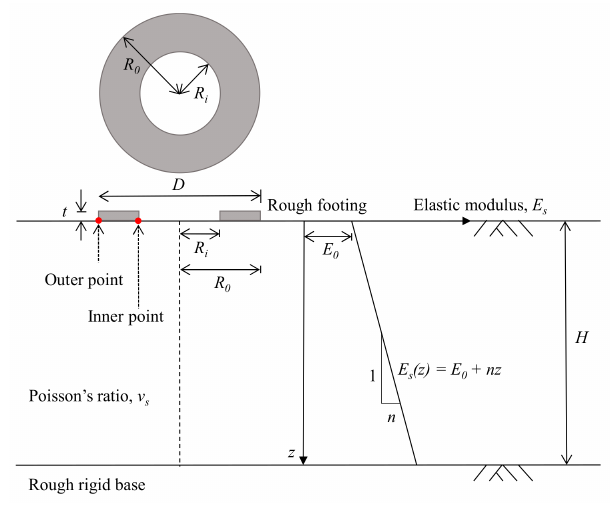
Figure 1. Problem